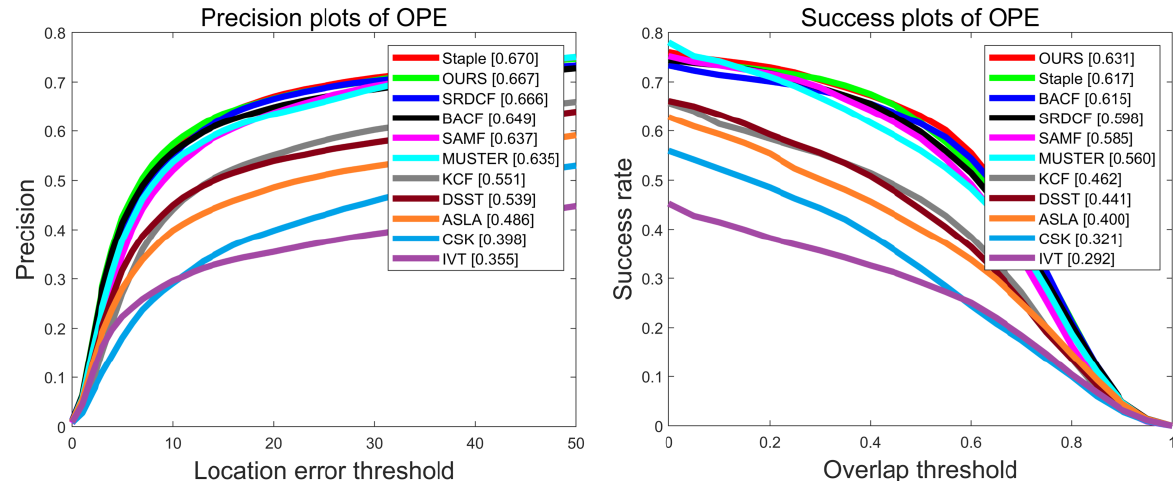
Figure 13. Accuracy and success rate plots of different algorithms tested on the TC128 dataset. Table 4. Average performance of algorithms tested on the TC128 dataset.